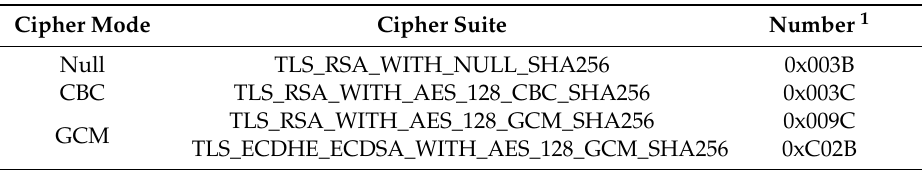
Table 1. Cipher suites defined by the specification